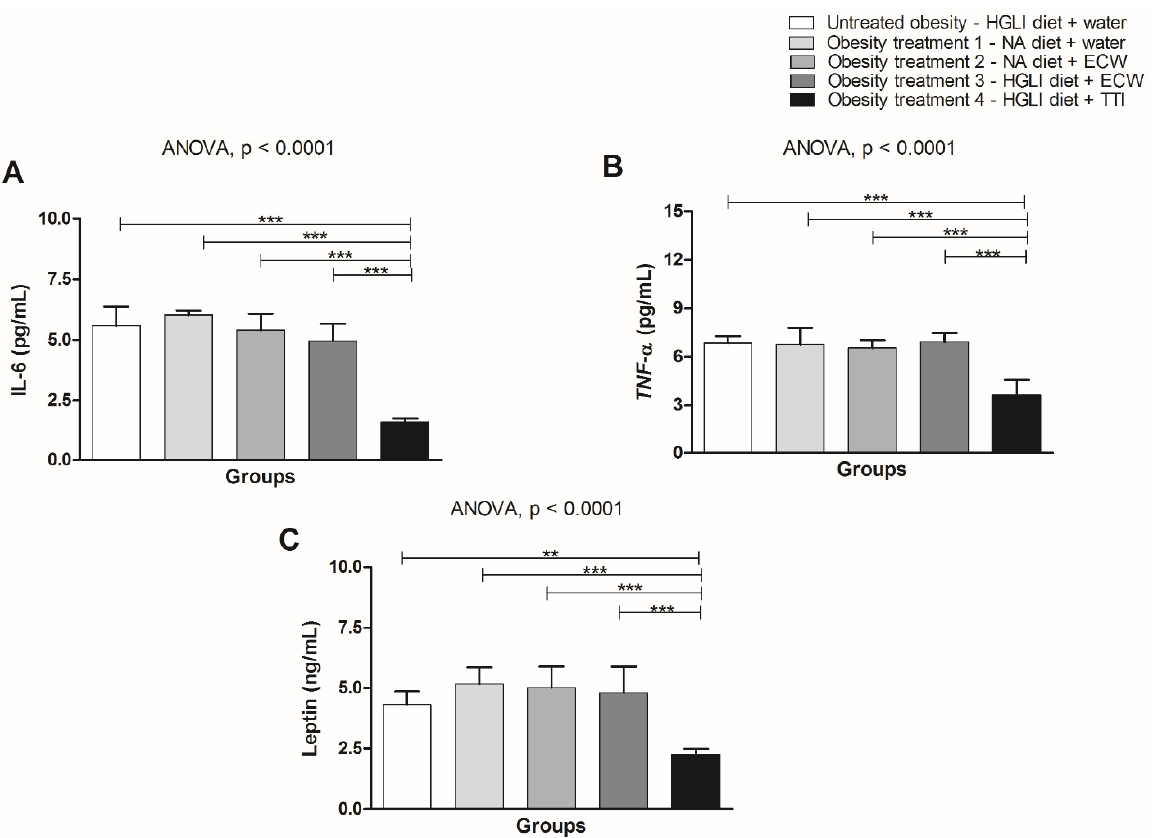
Figure 5. Inflammatory parameters and leptin dosage in obese Wistar rats submitted for ten days to different types of treatment: ( A ). IL-6; ( B ). TNF- α ; ( C ). Leptin. HGLI diet: high glycemic index diet and high glycemic load high glycemic index and high glycemic load diet, a mixture composed of Labina ® , condensed milk, and sugar (1:1:0.21 w / w / w ); NA diet: nutritionally adequate diet (standard diet) (Labina ® ); TTI: tamarind trypsin inhibitor; ECW: TTI encapsulated in purified chitosan and whey protein isolate (1:2:2 w / w / w ). Values are expressed as mean (standard deviation). The Kolmogorov– Smirnov test was used to assess data normality. The statistical difference was evaluated using ANOVA and Tukey’s post-test ( p < 0.05) for IL-6, TNF- α , and Leptin. Values of p ≤ 0.05 were considered statistically significant(; ** p < 0.01; *** p < 0.0001).